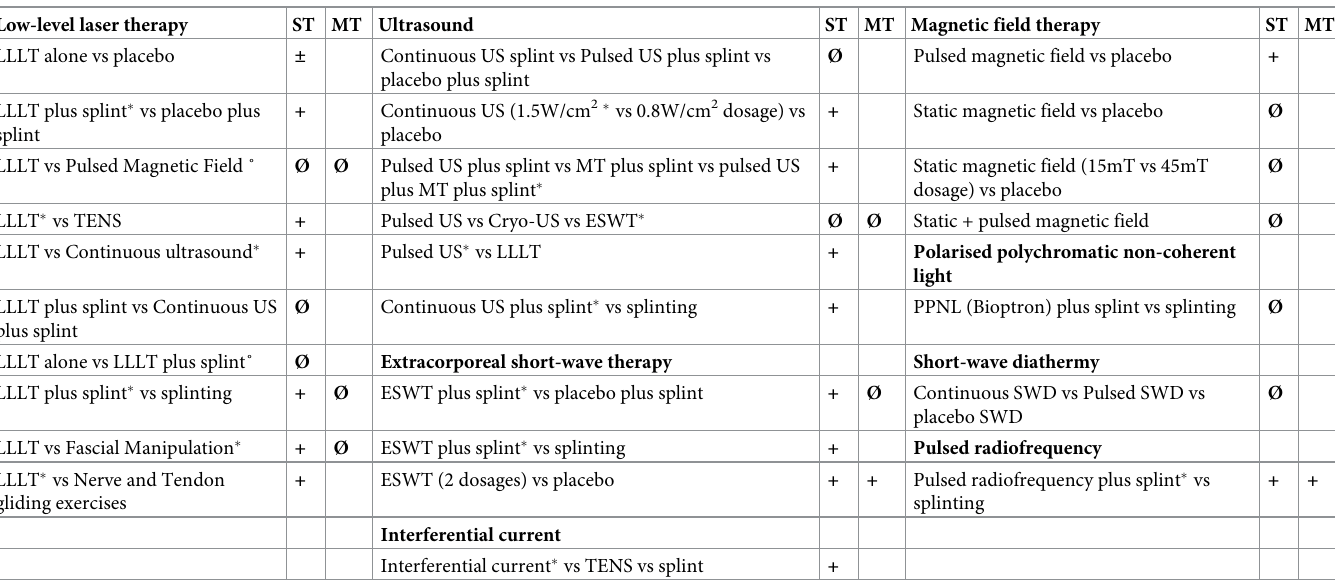
Table 6. Overview of evidence of electrophysical modalities. Low-level laser